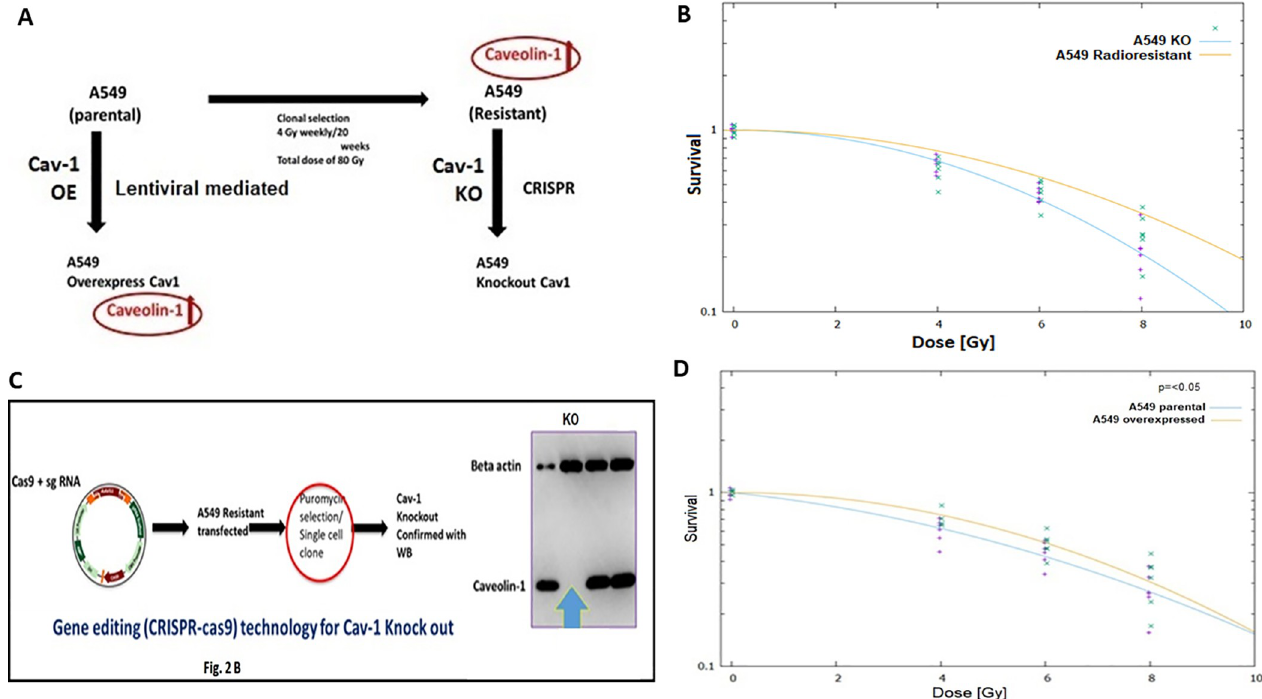
Fig 2. (A) Knock out of CAV-1 gene by CRISPR CAS9 and effect of its overexpression in radioresistant A549 lung cancer cells. (A) Schematic diagram of generating radioresistant, CAV-1 KO and CAV-1 overexpressing A549 cells from parental A549 cells. ( B ), Survival curve of A549 radioresistant (Red) and CAV-1 KO cells (Blue), representing absorbed radiation dose and survival fraction using Linear-Quadratic Model. ( C ), Schematic diagram of generating CAV- 1 knockout and CAV-1 overexpressing A549 cells by CRISPR-Cas9 gene editing technology. ( D ), Survival curve of A549 parental (Blue), and CAV-1 overexpressed cells (Red), representing absorbed radiation dose and survival fraction using Linear-Quadratic